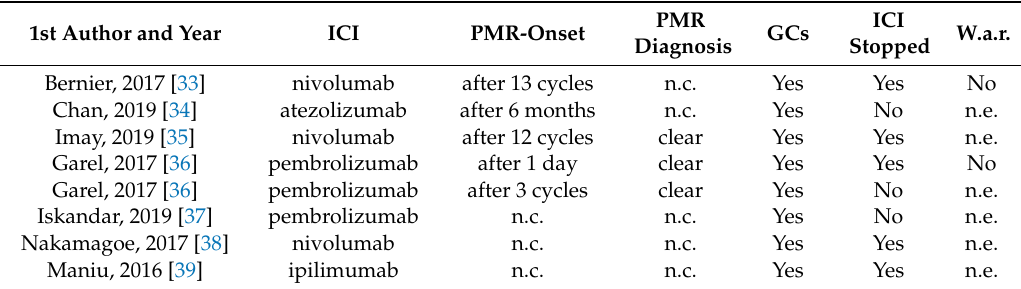
Table 1. Immune-related adverse e ff ects-Polymyalgia Rheumatica (IRAEs-PMR) case-reports included in our review.